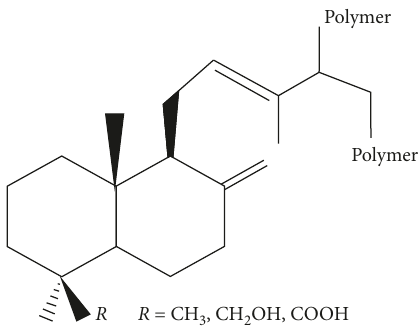
Figure 7: Class Ib resin structural unit.